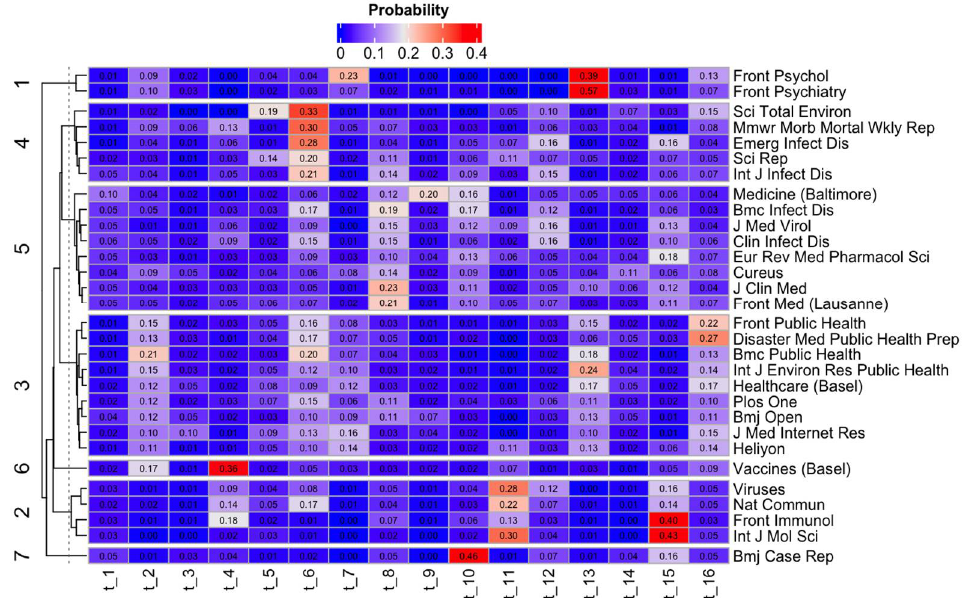
Figure 4. Heatmap overview of the proportional topic in the top-30 analyzed journals. Values are in percentages and row totals sum up to 100%.